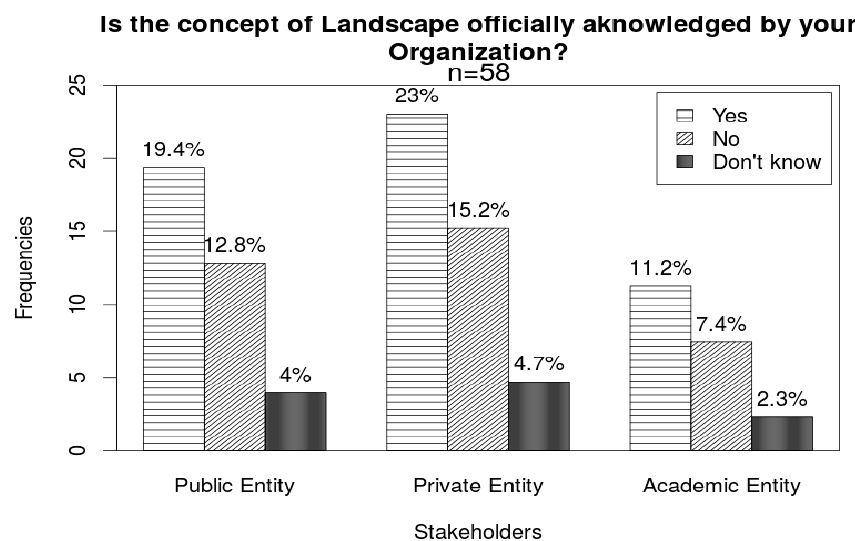
Figure 2. Frequencies of answers to the question “Is the concept of Landscape officially acknowledged by your Institution/Organization?” by stakeholder type.